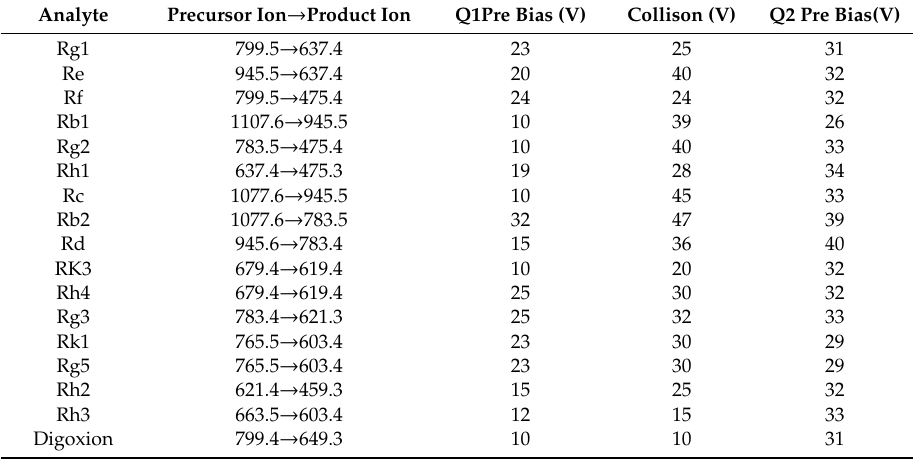
Table 1. Optimized precursor / product ion pairs and MRM parameters of the 16 analytes with digoxin (IS) in the negative ion mode.